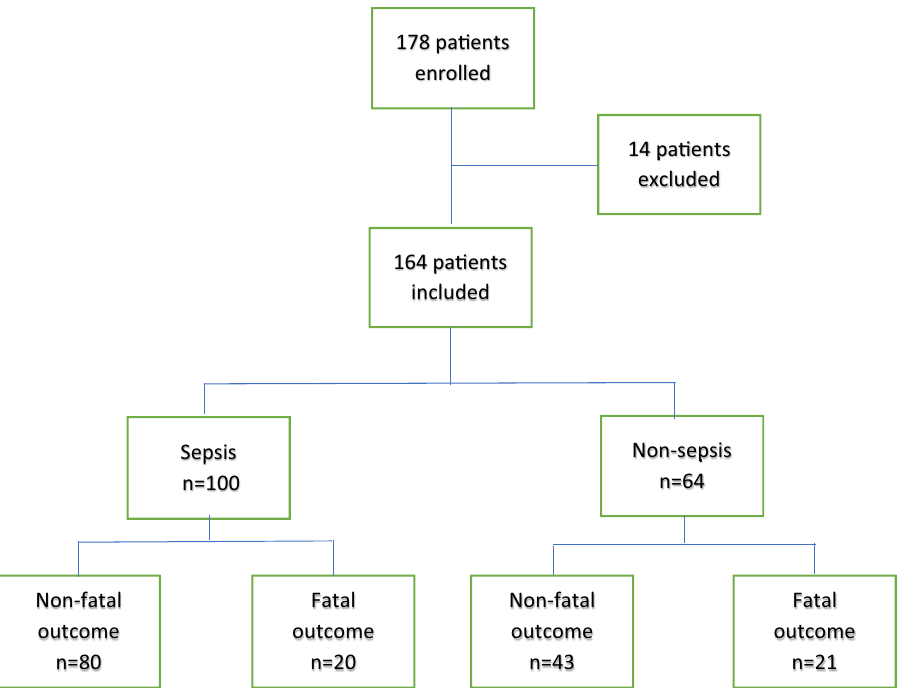
Figure 1. Patient flowchart. Fatal outcome equivalent to 28 days mortality. At 180 days, an additional four patients deceased in each group,